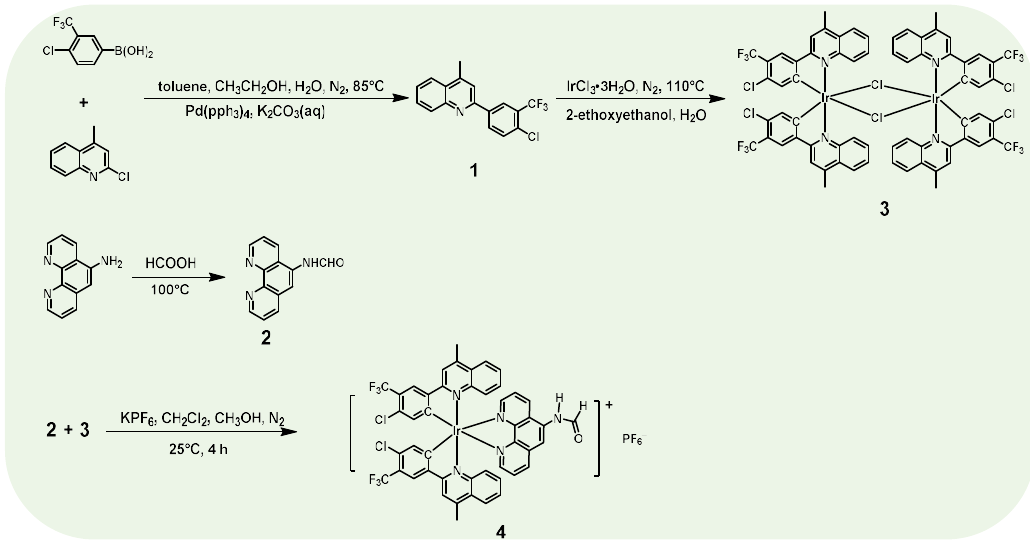
Figure 1. Synthetic routes of the iridium(III) complex.